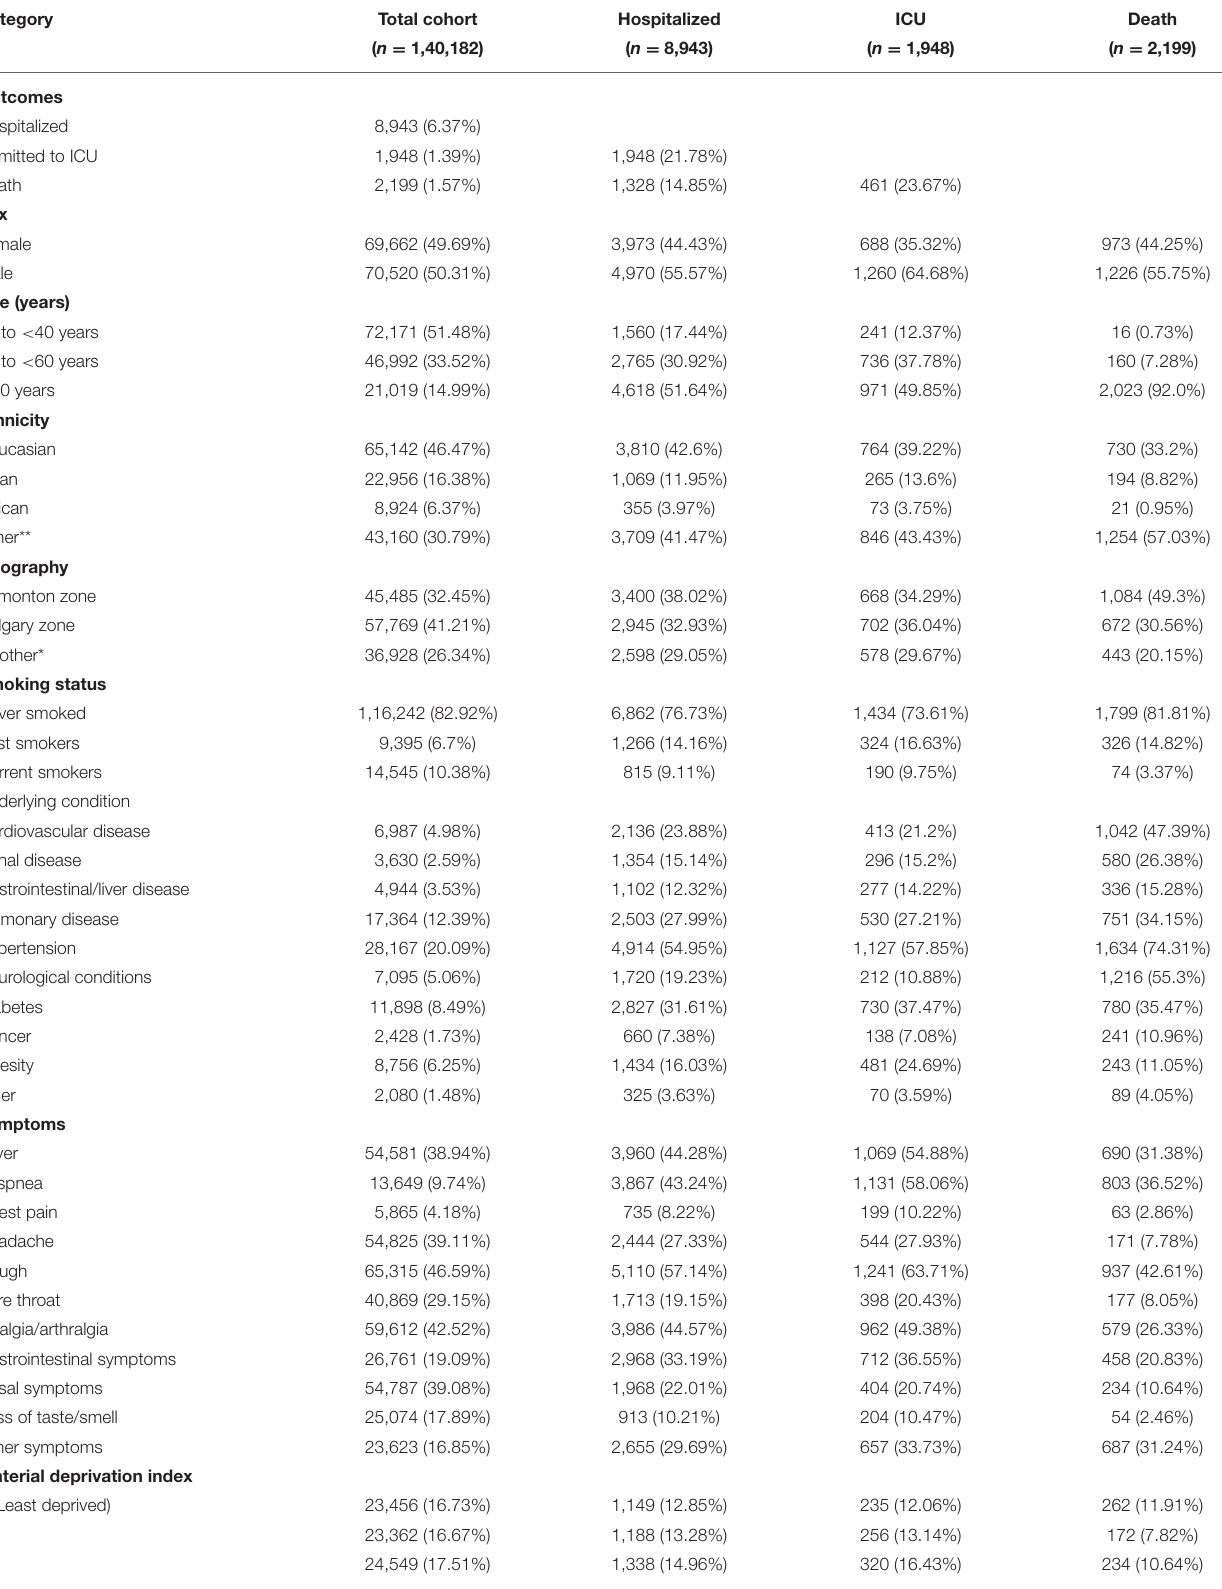
TABLE 1 | Distribution of the variables by outcome in the study